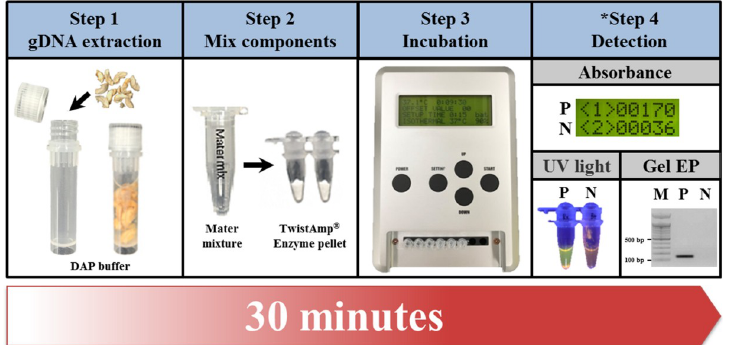
Fig 2. Schematic of the RPA assay for B . xylophilus in the field with the portable optical isothermal device (POID). P (green-colored) and N (orange-colored) represent the detection results of the absorbance levels (applied non-offset value) and UV light from the positive and negative controls, respectively. � In Step 4, the results of the RPA assay detected by UV light and agarose gel electrophoresis (Gel EP) were presented to help understand the interpretation. M indicates the 100 bp DNA ladder size